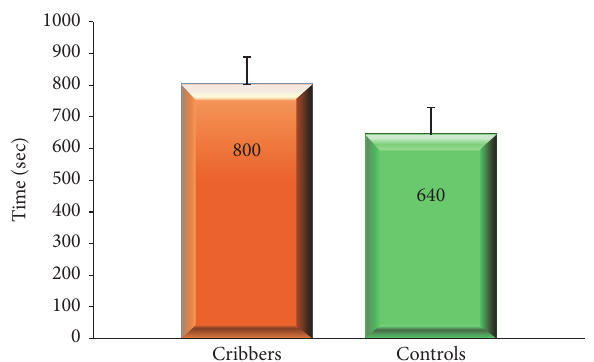
Figure 2: Time needed to finish the concentrate ration observed in CribbingandControlhorsesduringPre-Quarykaphaseofthestudy.